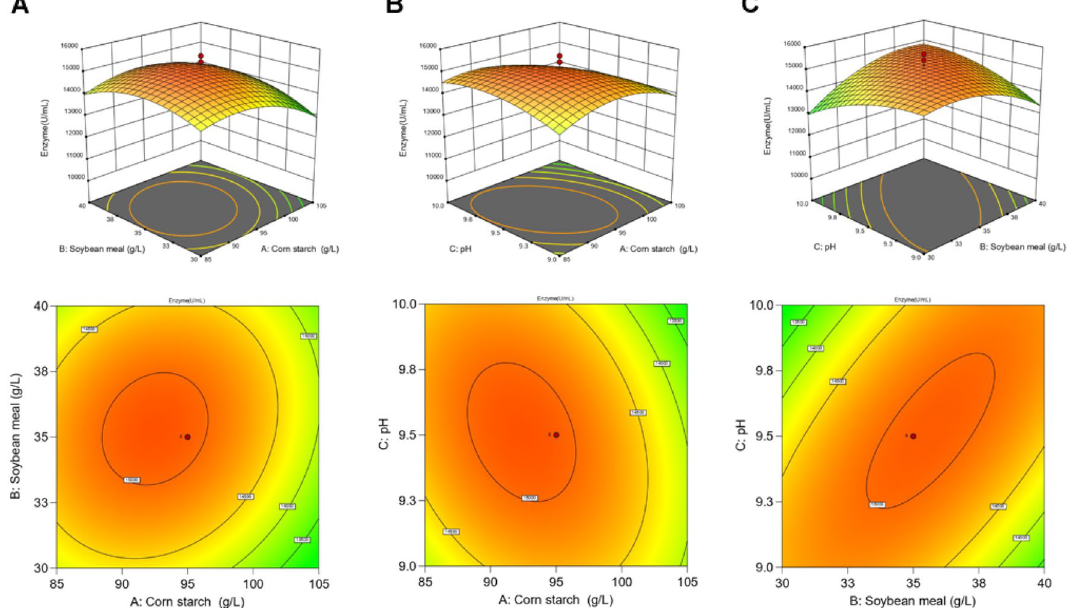
Fig. 3 Response surfaces and contour plots describing the interaction of different variables on alkaline protease production. Variables are soybean meal and corn starch contents ( A ), corn starch content and pH ( B ), and soybean meal content and pH ( C